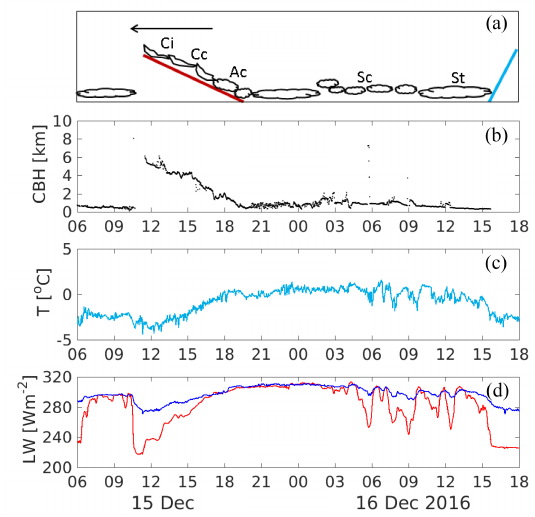
Figure 2. A frontal passage on 15/16 December 2016 in Ny- Ålesund. (a) Schematic diagram of the warm front (red line) and cold front (blue line), their moving direction (black arrow), and associated clouds (Ci: cirrus, Cc: cirrocumulus, Ac: altocumulus, Sc: stratocumulus, St: stratus), respectively. (b) Cloud base height (CBH) from ceilometer measurements. (c) 2m air temperature from surface meteorological observations. (d) Upward and downward long-wave radiation (blue and red lines, respectively) from surface radiation